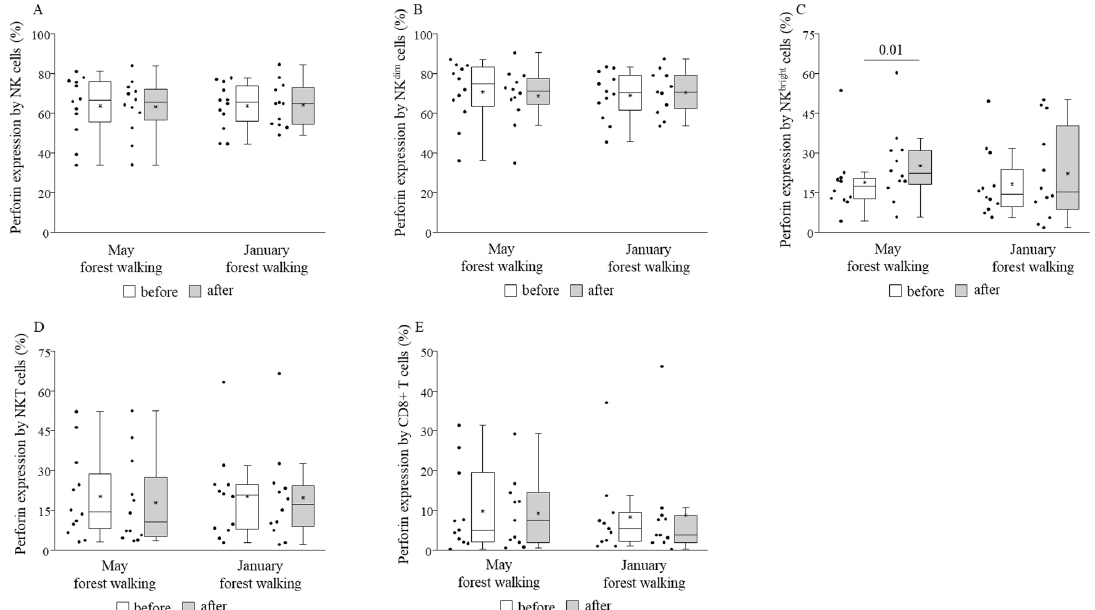
Figure 6. Perforin expressions by total NK ( A ), NK dim ( B ), NK bright ( C ), NKT ( D ), and CD8+ T ( E ) cells prior to and following the late spring (May) and winter (January) forest walks. The middle line within the box represents the median, the middle dot within the box represents the mean, the boxes indicate the interquartile ranges between the 25th and 75th percentiles, and the whiskers show the most extreme observations in the box plot. Individual dots left from the boxes represent individual data values. Differences were considered statistically significant for p -values < 0.05. Statistically significant p -values are indicated on the horizontal lines outside the boxes.